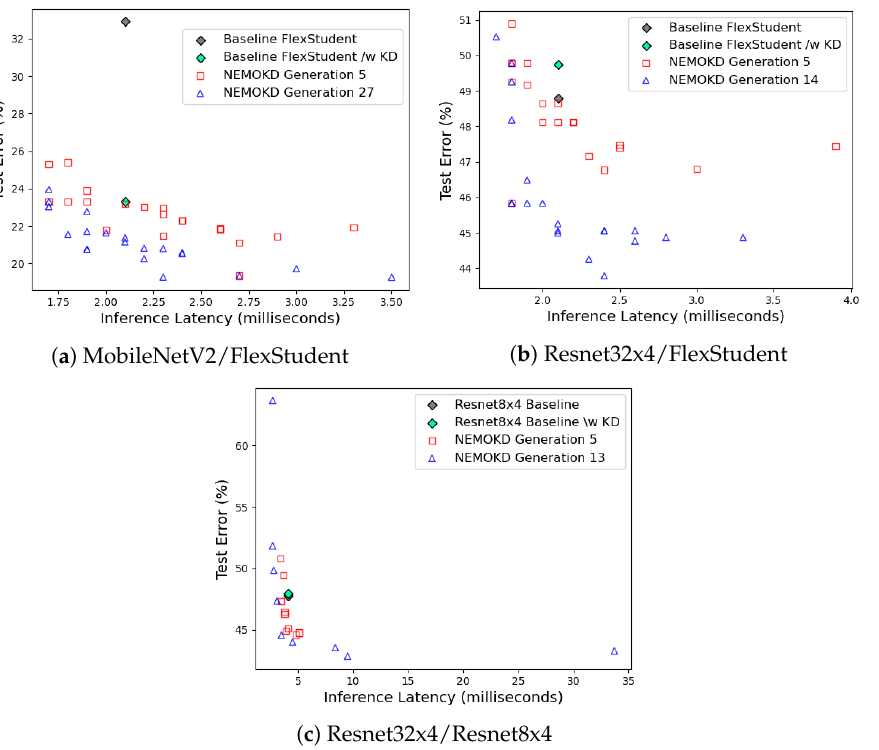
Figure 10. Student latency and accuracy performance for Teacher/Student